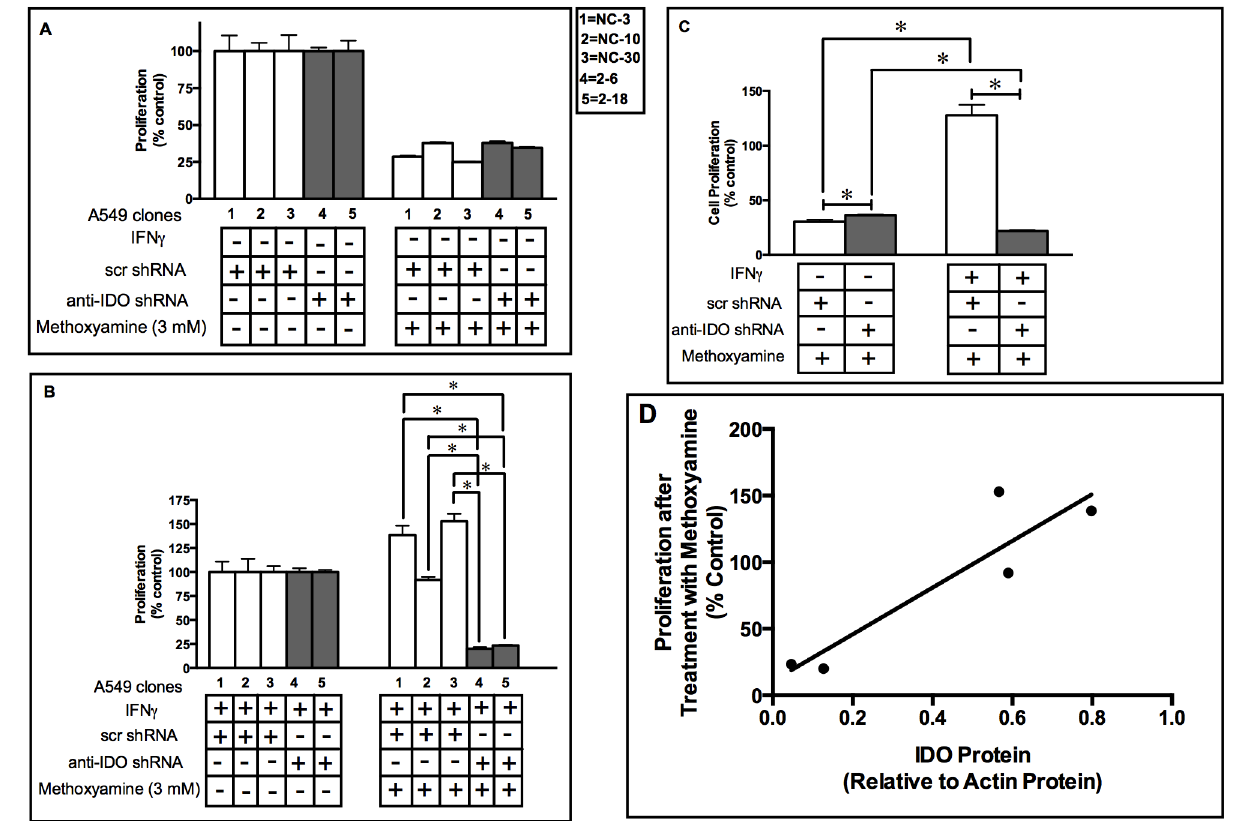
Fig 2. A549 clone sensitivity to methoxyamine (3 mM) before and after IDO induction. Proliferation of each of 5 individual A549 cell clonal populations before ( Panel A ) and after ( Panel B ) IDO induction with IFN γ . A549 clonal populations were cultured with or without IFN γ (25 ng/ml) for 48 h. Cultured medium was then replaced with fresh growth medium containing Methoxyamine (MX) (3 mM) and cells were allowed to proliferate for 72 h. Cells were then trypsinized and live cells were enumerated. White bars : A549 clones transfected with scrambled, non-targeting control shRNA. Gray bars : A549 cells transfected with anti-IDO shRNA. Each bar represents the mean of 3 values ( n = 3 for determination of each value) ± SD. Results are normalized to control cells not treated with methoxyamine, without (panel A) or with (panel B) IFN γ treatment. Panel C : Induction of IDO in A549 clonal cell populations induces resistance to MX (3 mM). Results were obtained from 3 or 2 independent clonal cell populations with scrambled, non-targeting control shRNA or anti-IDO shRNA, respectively. Each bar represents a mean of 9 (white bars) or 6 (black bars) values ± SEM, * Significant difference, Student's t -test, p < 0.05. Panel D : Relationship between IDO protein level (relative to actin) and resistance to methoxyamine (MX)(proliferation relative to untreated control cells). The R 2 value of 0.83 represents a moderate positive